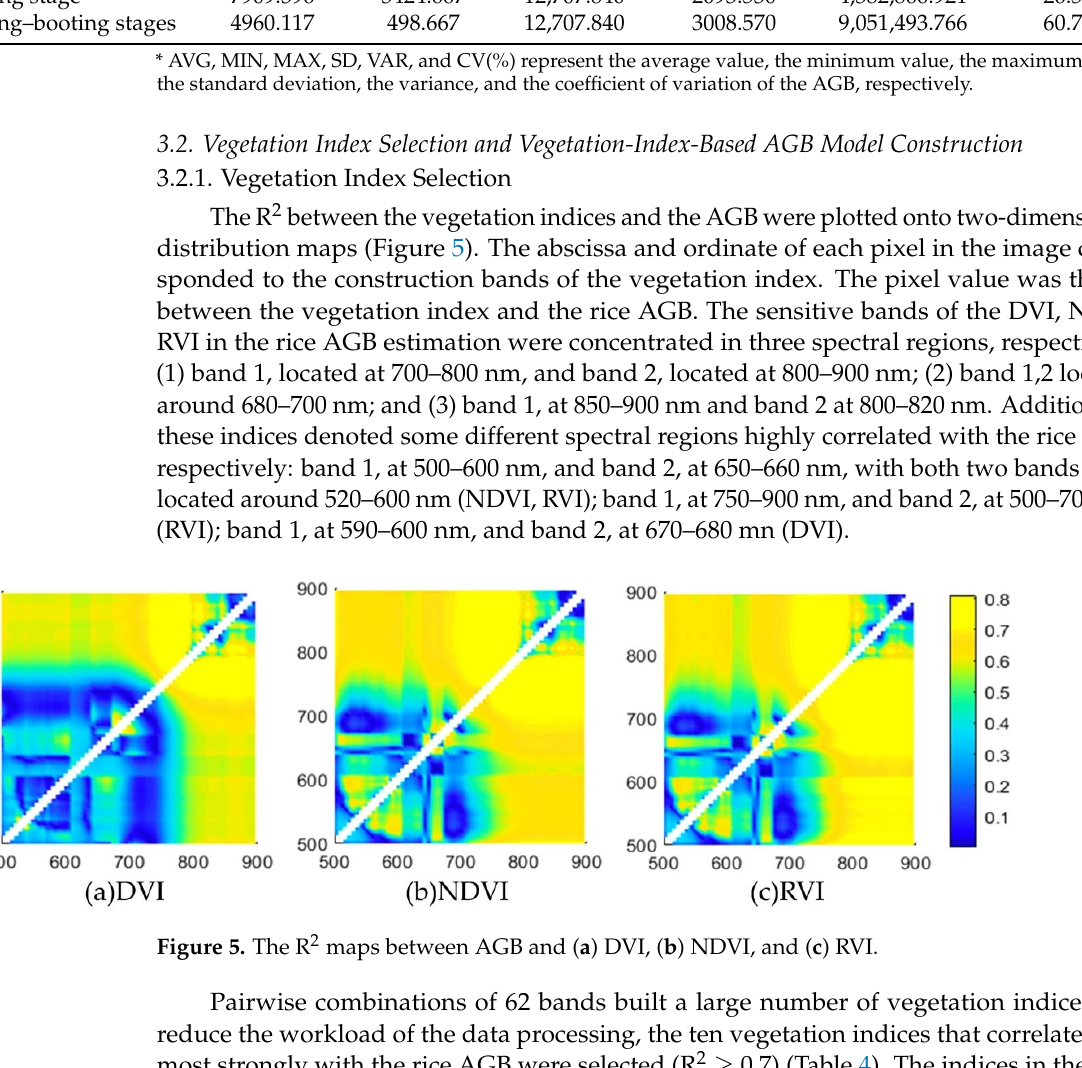
Table 3. Statistical analysis of AGB values at different growth stages.